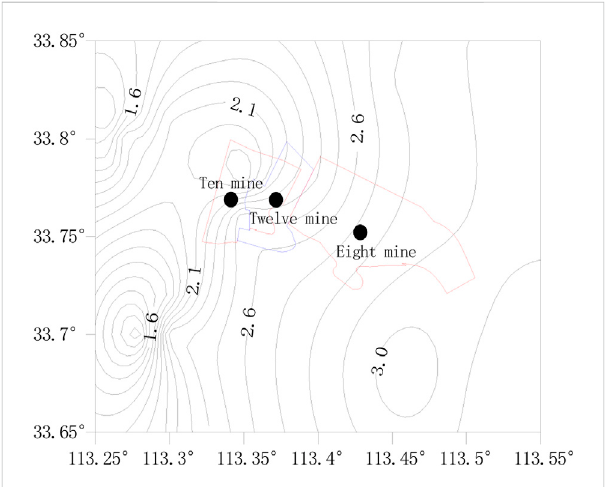
FIGURE 11 Comparison results of coal and gas outburst and other mine dynamic disasters with natural earthquake magnitude (M S >